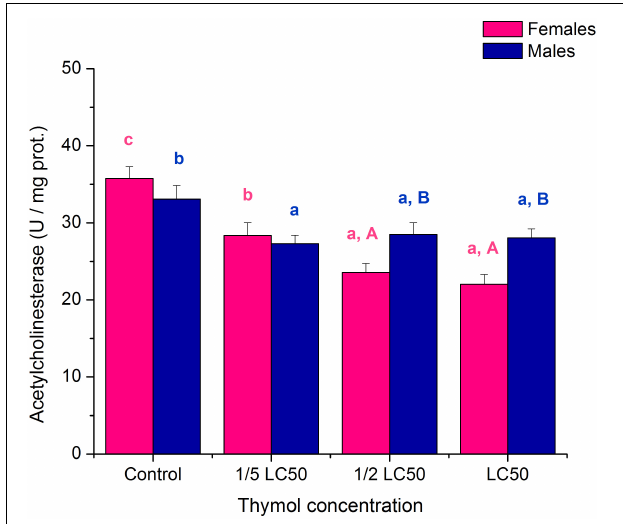
FIGURE 4 | Activity of acetylcholinesterase (mean ± SE for 5 replicates) in females and males of Acanthoscelides obtectus exposed to different thymol concentrations. Different lowercase letters (a, b, c) mark significant differences among concentrations within each sex (Duncan’s post-hoc test, p < 0.05), whereas different uppercase letters (A, B) show significant differences between females and males within each thymol concentration (LSM contrasts, p <